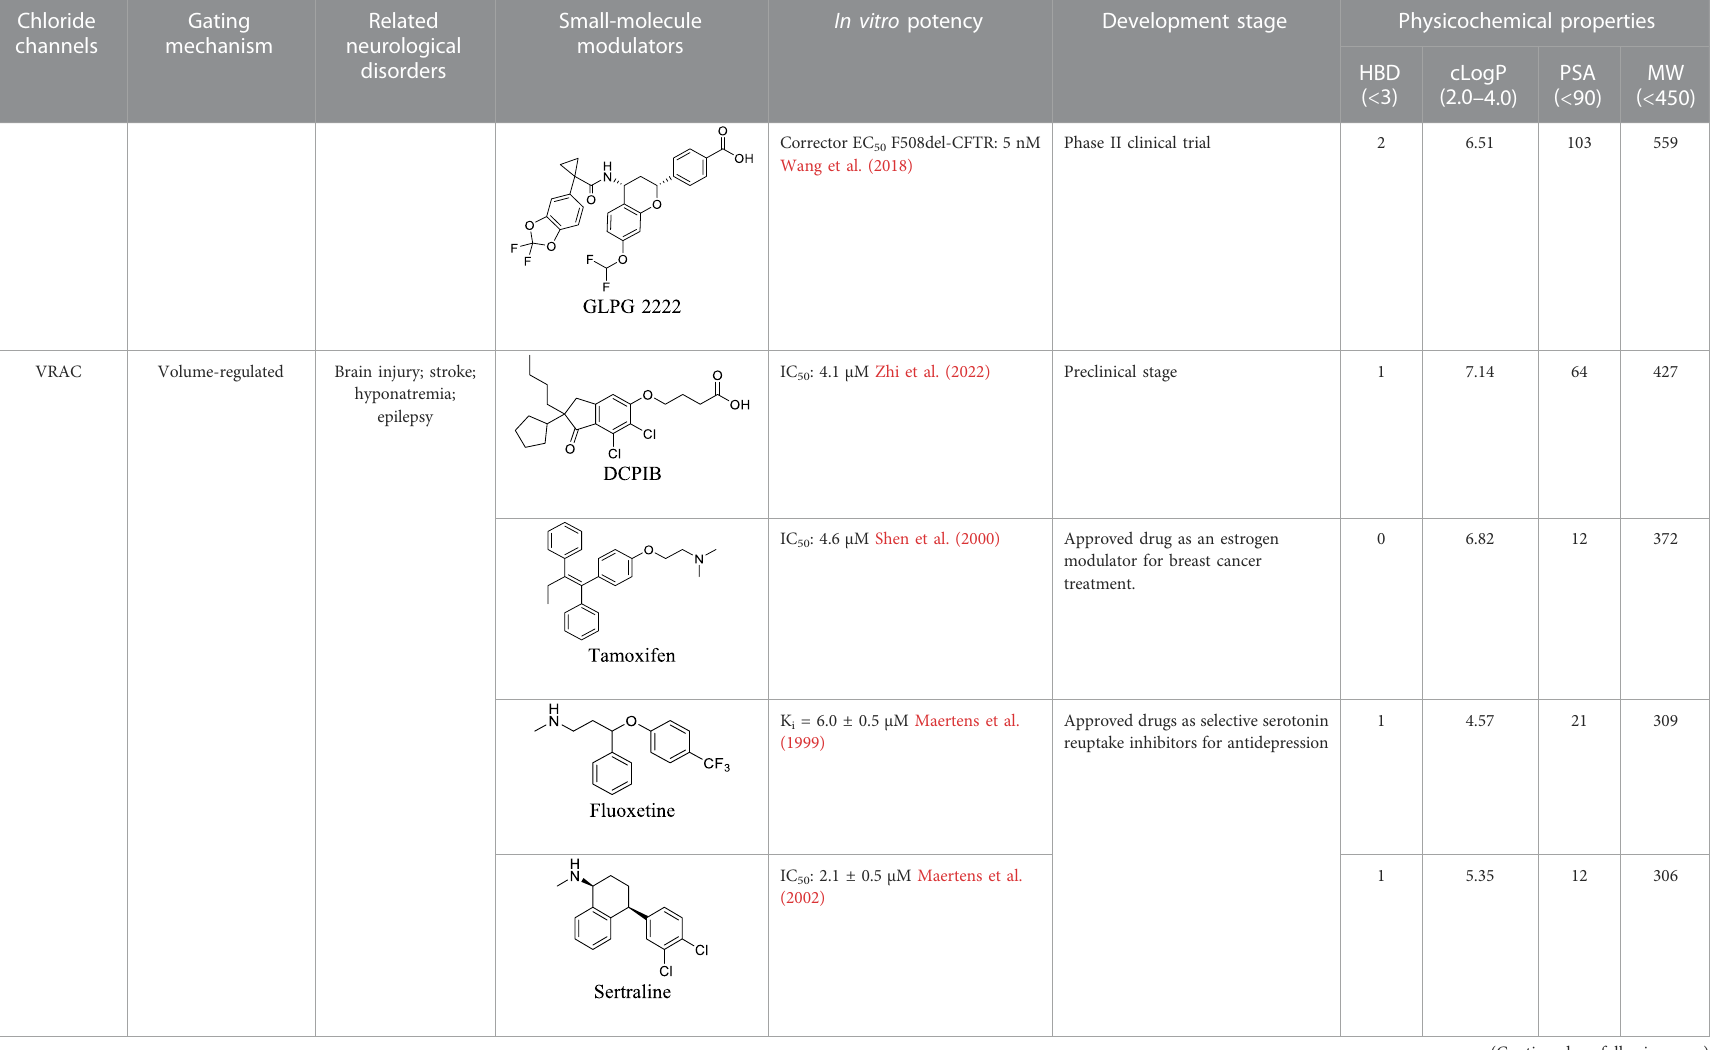
TABLE 1 ( Continued ) Summary of chloride channels involved in neurological disorders and their small-molecule modulators with physiochemical